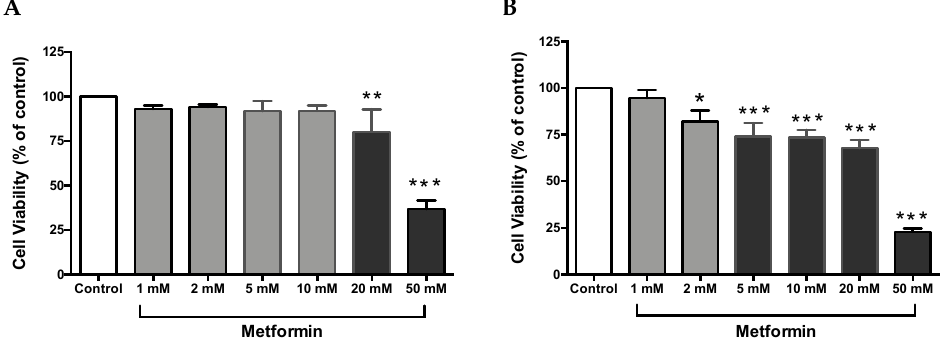
Figure 1. Metformin reduced cell viability in Caki-1 and Caki-2 renal cancer cell lines. ( A ) Caki-1 and ( B ) Caki-2 cells were incubated in the absence (control) or presence of metformin (1, 2, 5, 10, 20, and 50 mM) for 48 h. Cell viability was analyzed using Alamar Blue™ assay, and the fluorescence values were normalized to control and expressed as the percentage of control. Data are presented as mean ± SEM ( n = 4–5 per group). * P < 0.05; ** P < 0.001; and *** P < 0.0001 vs. control.